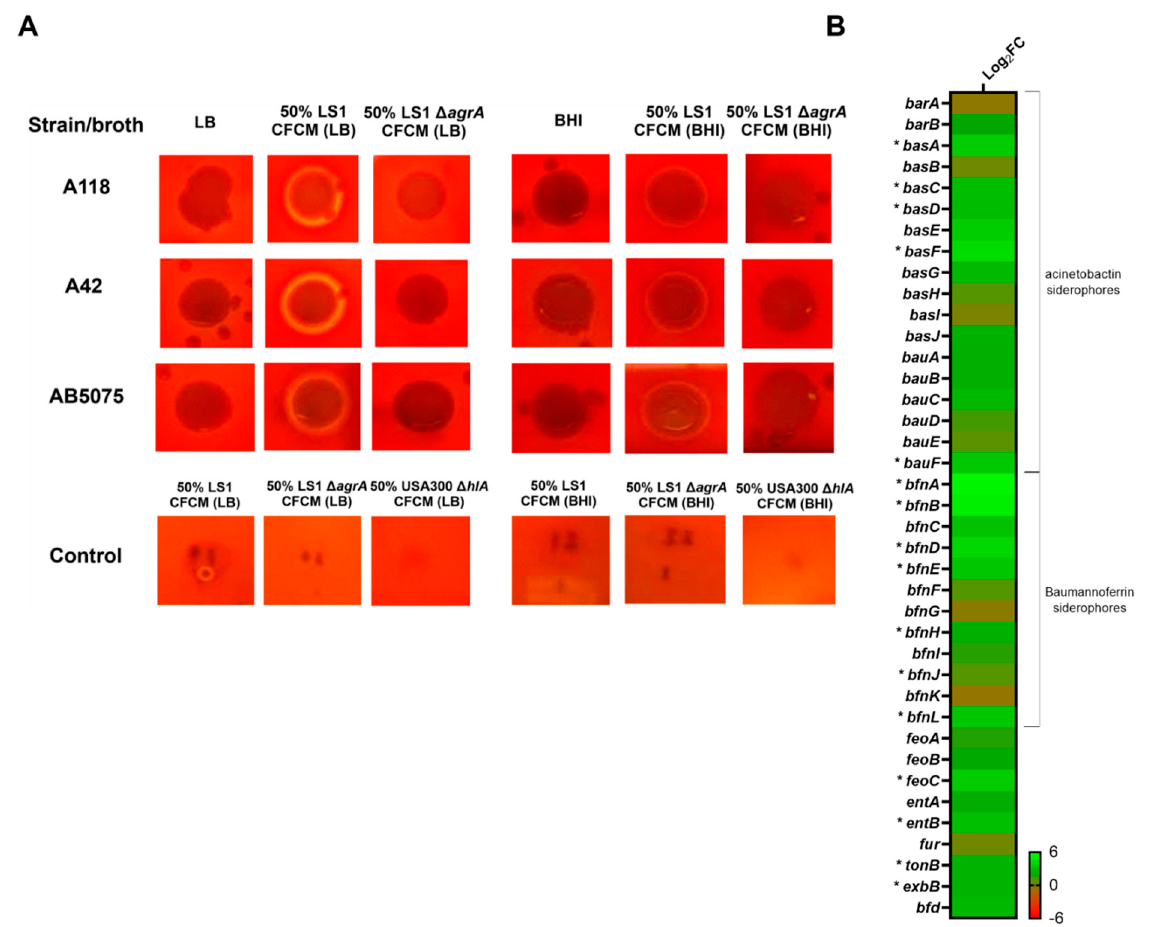
Figure 3. Phenotypic and genetic analysis of iron acquisition and metabolism coding genes. ( A ) Hemolytic activity was performed for A. baumannii A118, A42 and AB5075 strains in presence or absence of different CFCM obtained from LB or BHI broth. The control condition corresponds to LB or BHI supplemented with CFCM, without A. baumannii cells. ( B ) Heatmap showing the differential expression of genes associated with iron acquisition and metabolism. DEG are indicated with an asterisk (FDR <